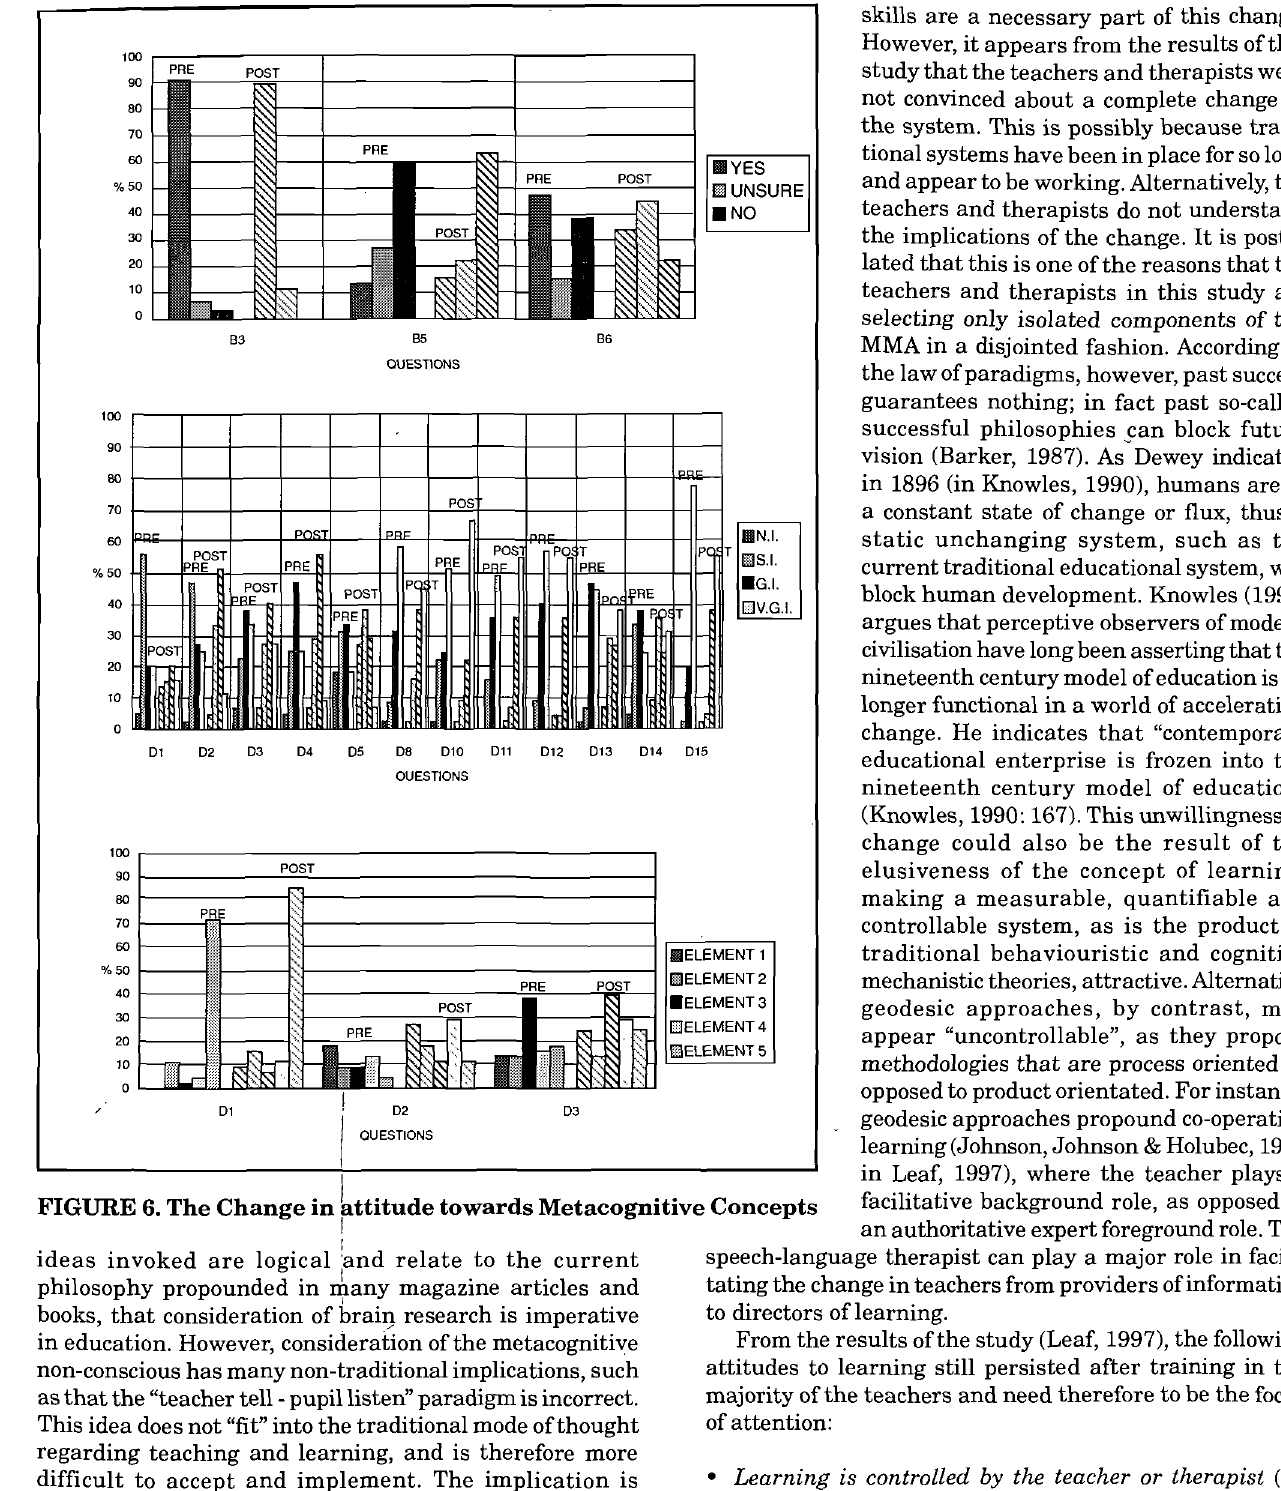
FIGURE 6. The Change in